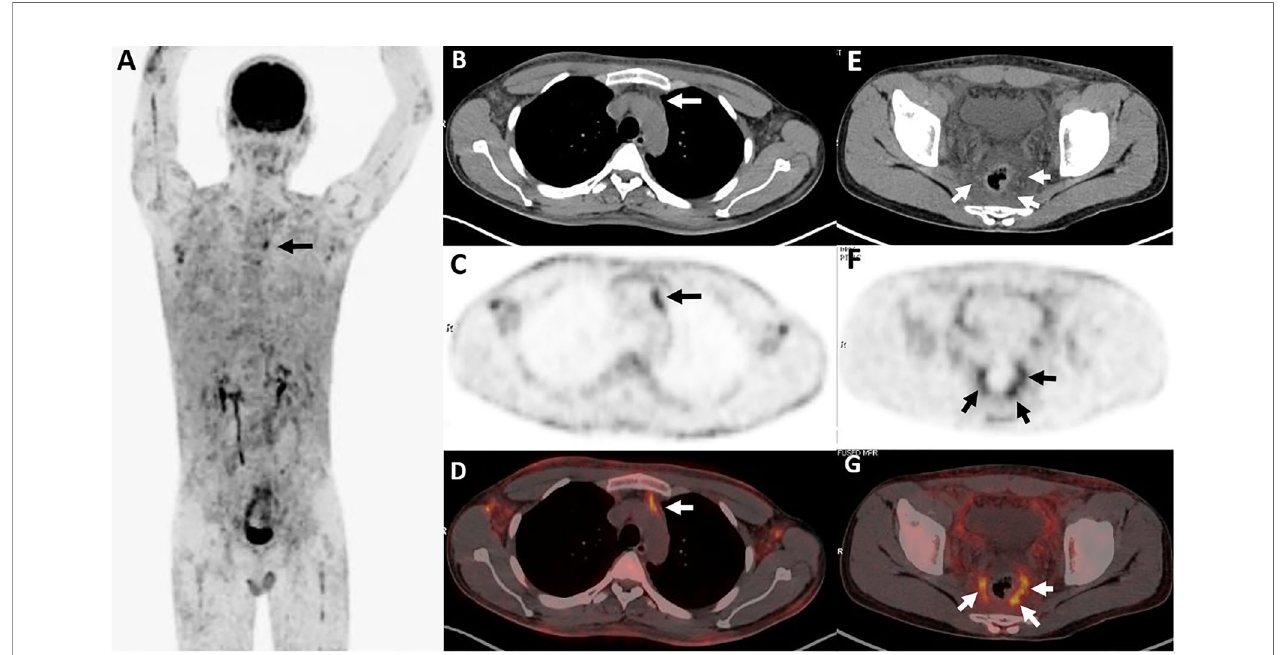
FIGURE 5 | Twenty- fi ve-year-old male with subcutaneous panniculitis-like T-cell lymphoma. Three-dimensional maximum intensity projection PET image (A) shows diffuse hypermetabolic lesions in the subcutaneous of the body. Thoracic axial CT (B) , corresponding PET (C) and fusion PET/CT (D) images show a poorly de fi ned lesion with high uptake of 18 F-FDG in the anterior mediastinum (arrows). Pelvic axial CT (E) , corresponding PET (F) , and fusion PET/CT (G) images show perirectal lesions are positive on PET scan but negative on CT scan.